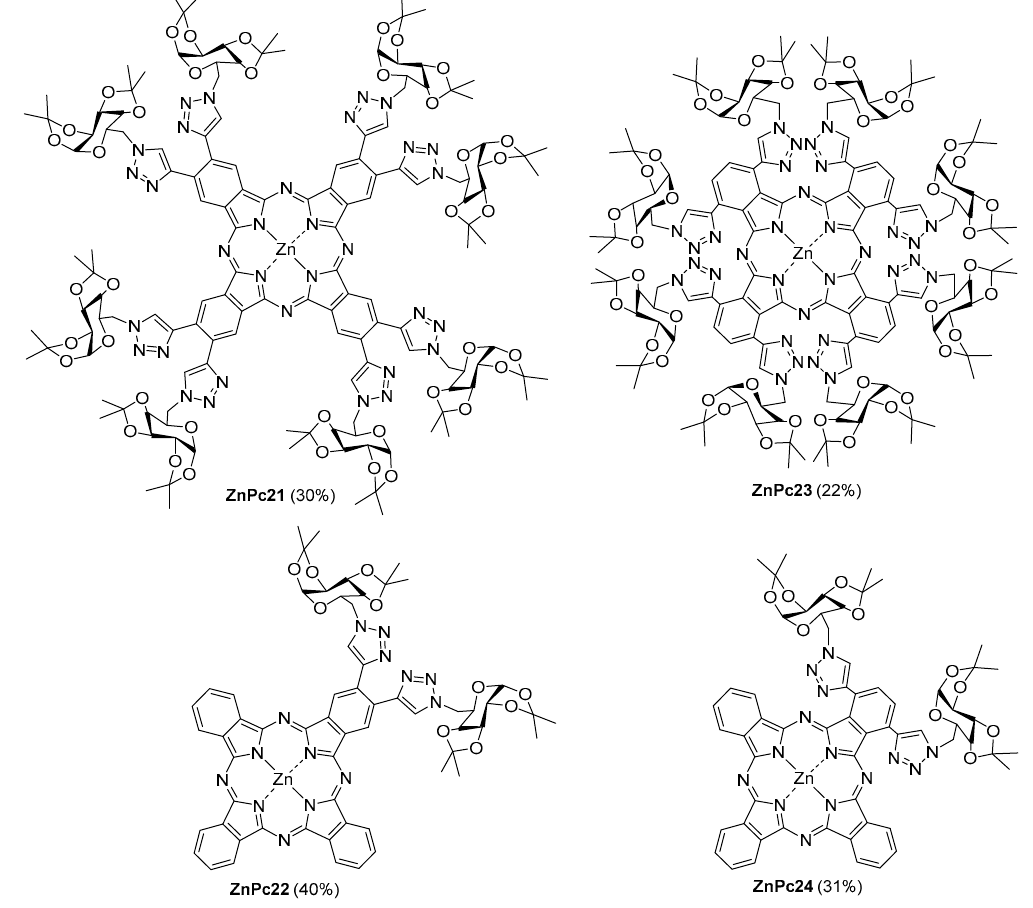
Figure 2. Structures of the galactoconjugated ZnPc21 – 24 .